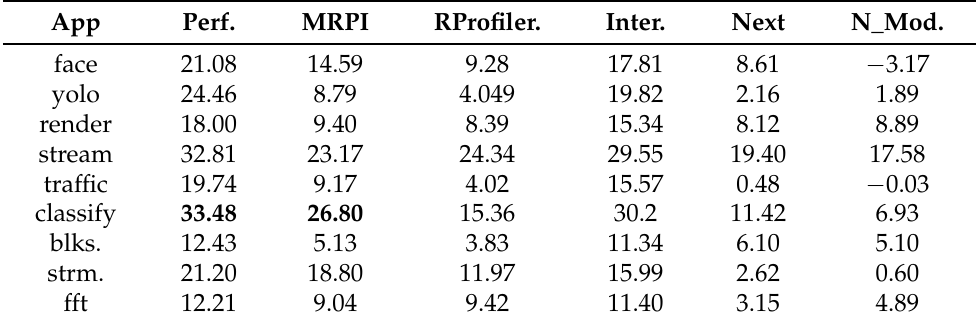
Table 4. Reduction in peak temperature of big CPUs (%) of CGM-DVFS compared to performance (perf.), MRPI, RewardProfiler (RProfiler.), interactive (inter.), Next and Next_Mod (N_Mod.). App Perf. MRPI RProfiler. Inter. Next N_Mod. face render stream